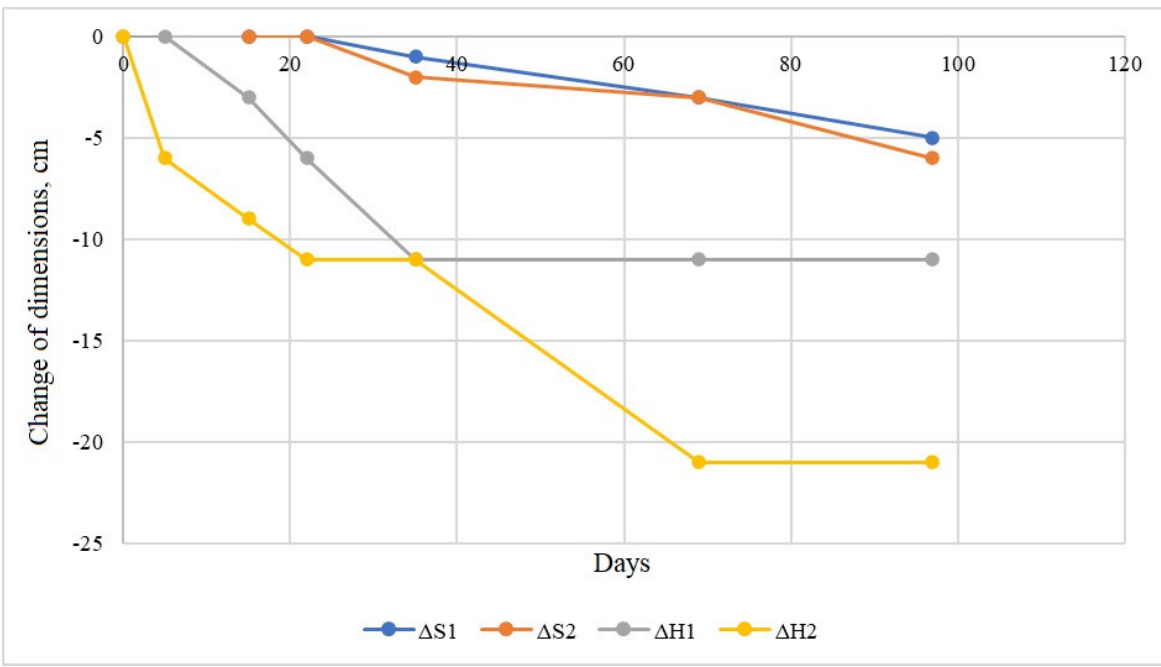
Figure A8. Change of the roadway dimensions—convergence control station no. 4.